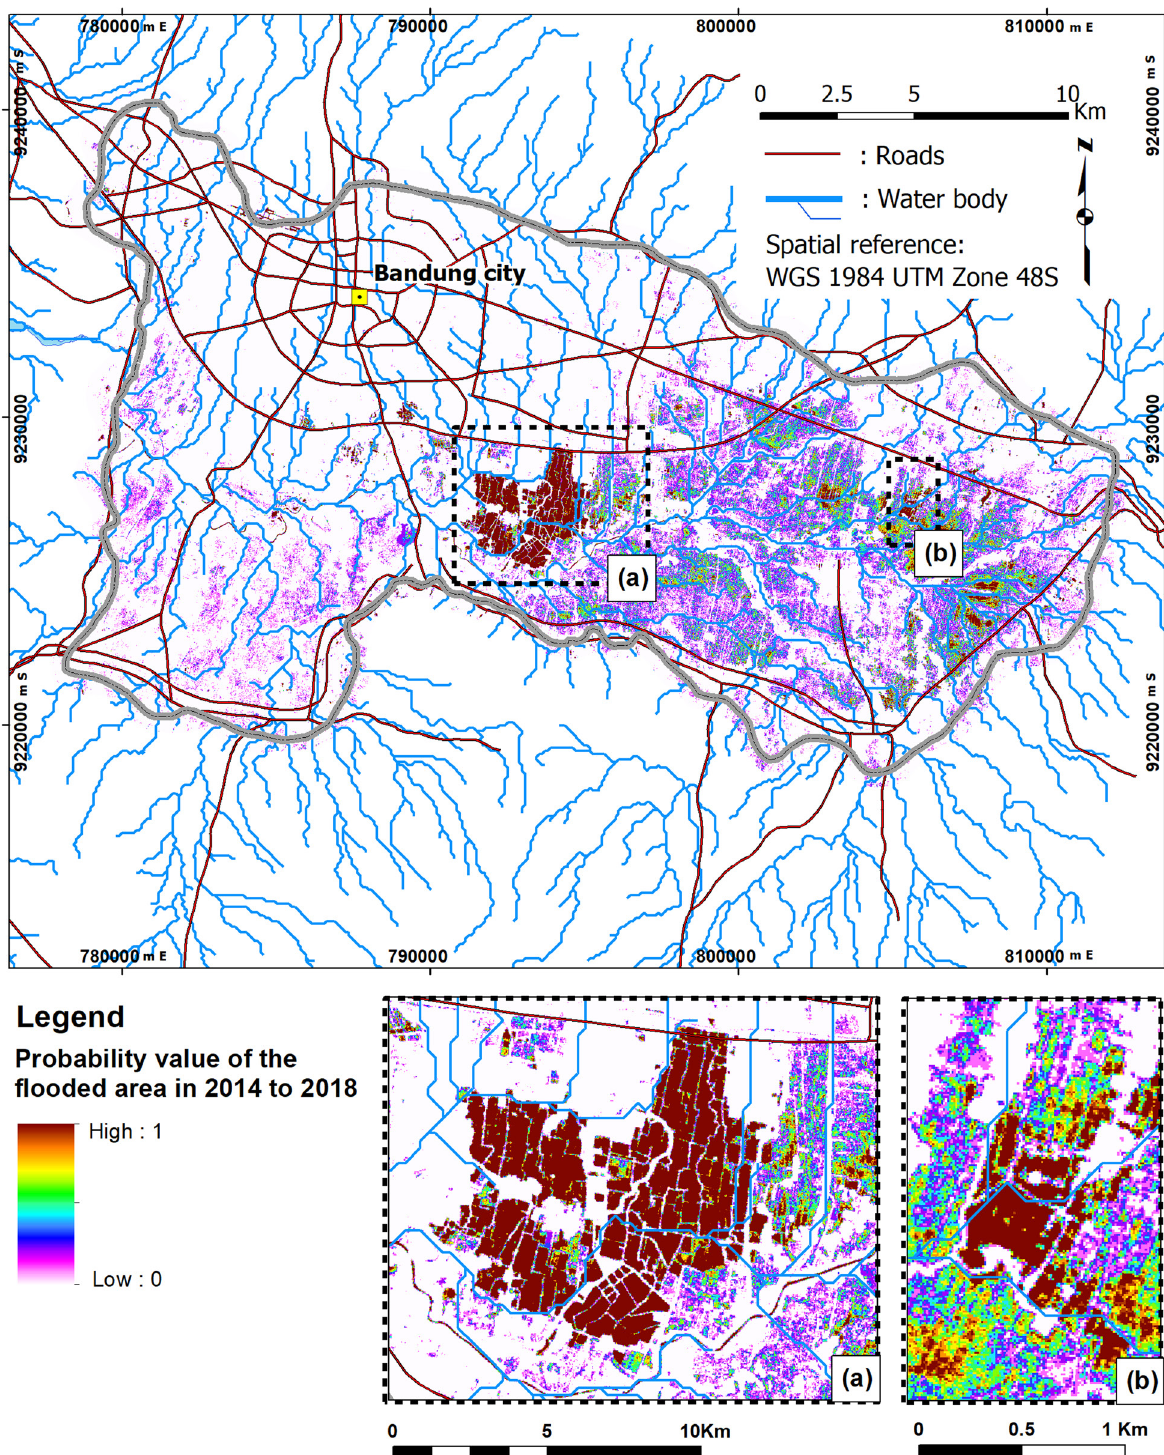
Fig. 9. Probability map for flood inundation from 2014 to 2018 in the study